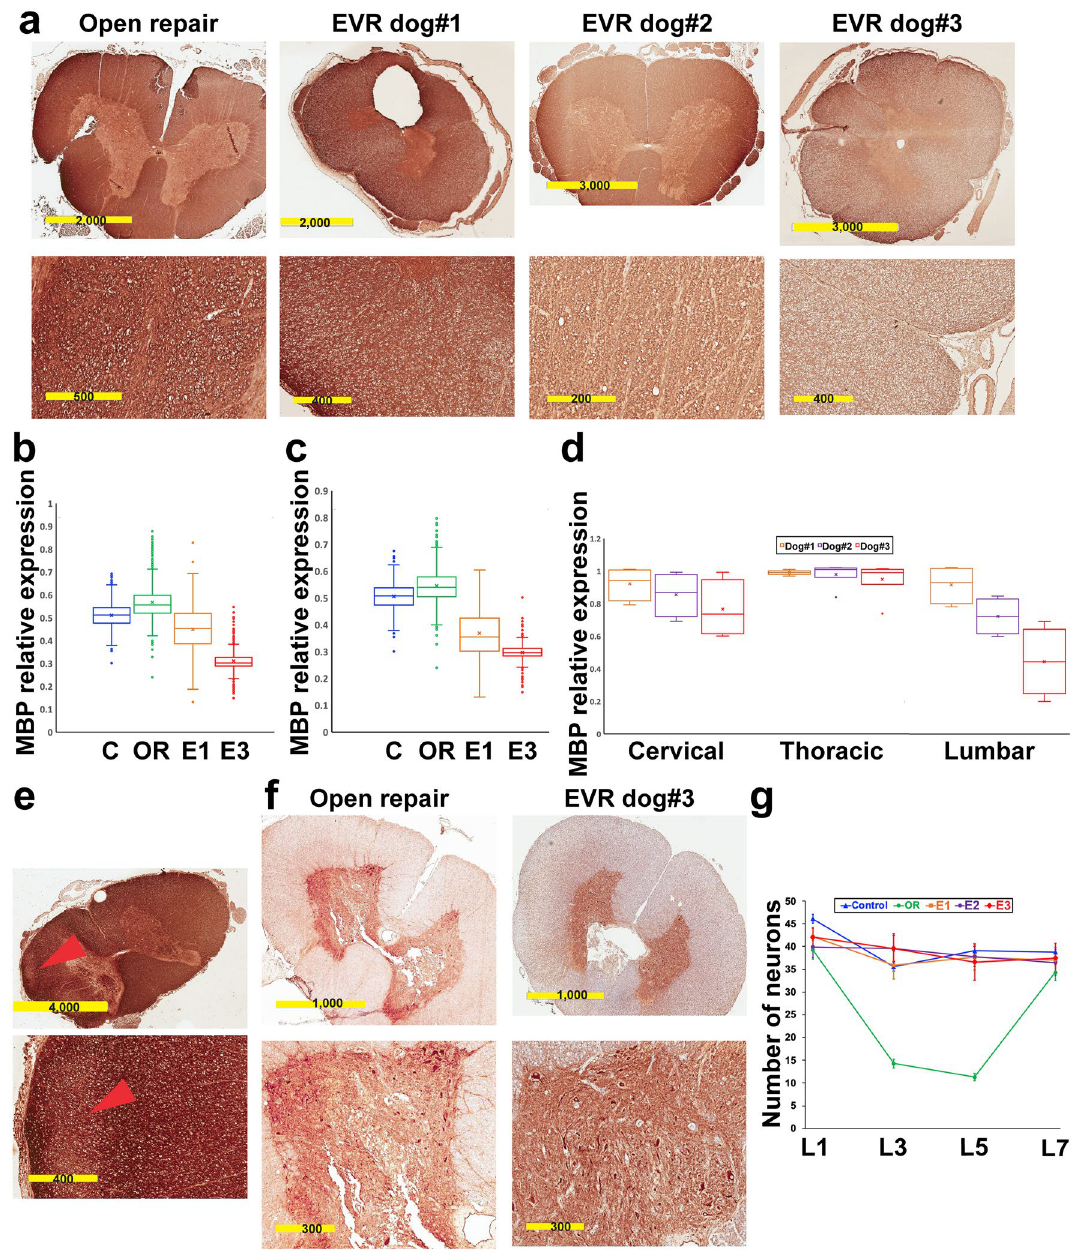
Figure 3. EVR primarily causes injury to the white matter. ( a ) Immunohistochemistry for myelin basic protein (MBP) in EVR dogs #1–3 versus OR. Cross-sections were at L5 level. ( b ), ( c ) Box and whisker plots showing MBP levels assessed by IHC on cross-sections of the SC throughout the L1–L5 region ( b ) or the T13–L3 region ( c ). C, control; OR, open repair; E1 and E3, EVR dog#1 and dog#3, respectively. Horizontal bars show the lower (first quartile), the median (second quartile) and the upper (third quartile) quartiles from bottom to top. The cross represents the mean value. ( d ) Box and whisker plots showing the dispersion of the mean levels of MBP expression in the cervical (C1, C3, C5 and C7), thoracic (T3, T5, T7, T9, T11 and T13) and lumbar (L1, L3, L5 and L7) regions of the SC of EVR dogs #1–3. ( e ) Reduced MBP level (arrowheads) in the cervical SC of EVR dog#2. ( f ) IHC for neurofilament heavy polypeptide in EVR dog#3 versus OR. Cross sections were at L5 level. ( g ) Neuronal density at the L1, L3, L5 and L7 levels in a control dog, an OR dog, and EVR dog#1 (E1), dog#2 (E2) and dog#3 (E3) was quantified by assessing the number of neurons per 10X field (given as mean ± standard deviation) as determined by pyruvate dehydrogenase testing. Scale bars are in